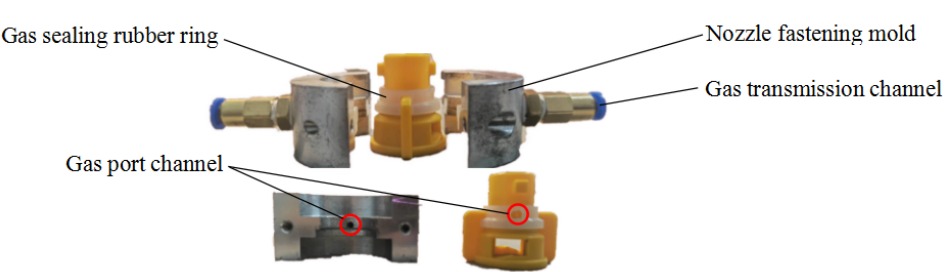
Figure 3. ALR measurement test.